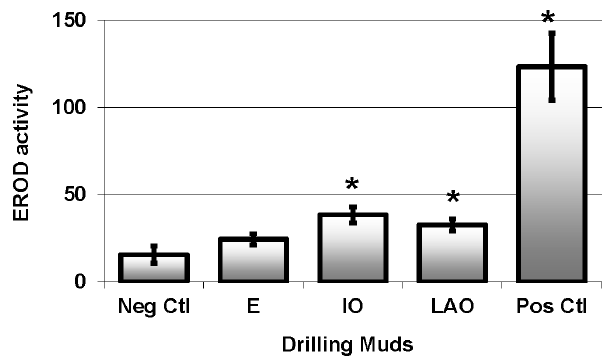
Figure 1. EROD activity (pmol resorufin/mg pro/min, mean 6 SEM) in pink snapper exposed to 5% v/v synthetic-based drilling muds for 28 days. * indicates statistically different from negative control fish.